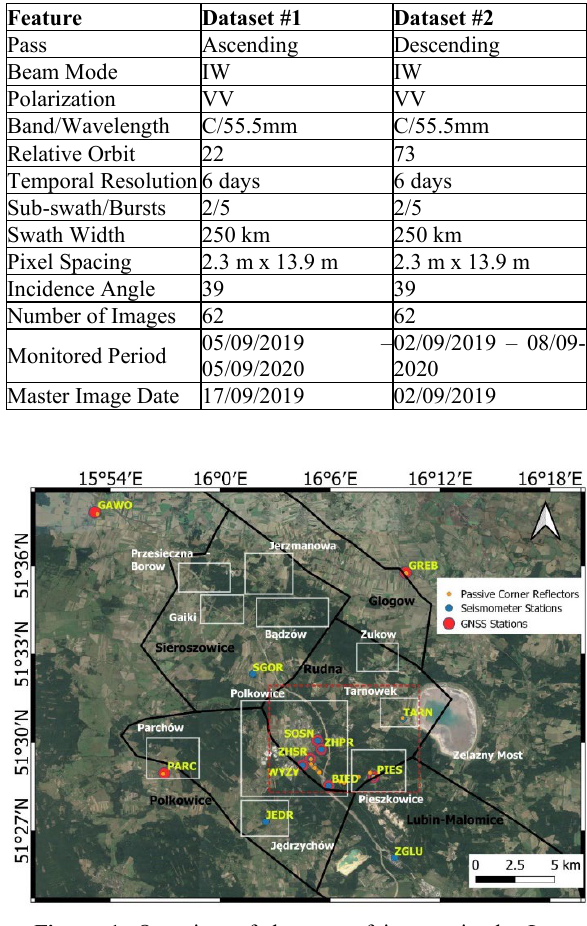
Table 1. Summary of the analysed datasets.